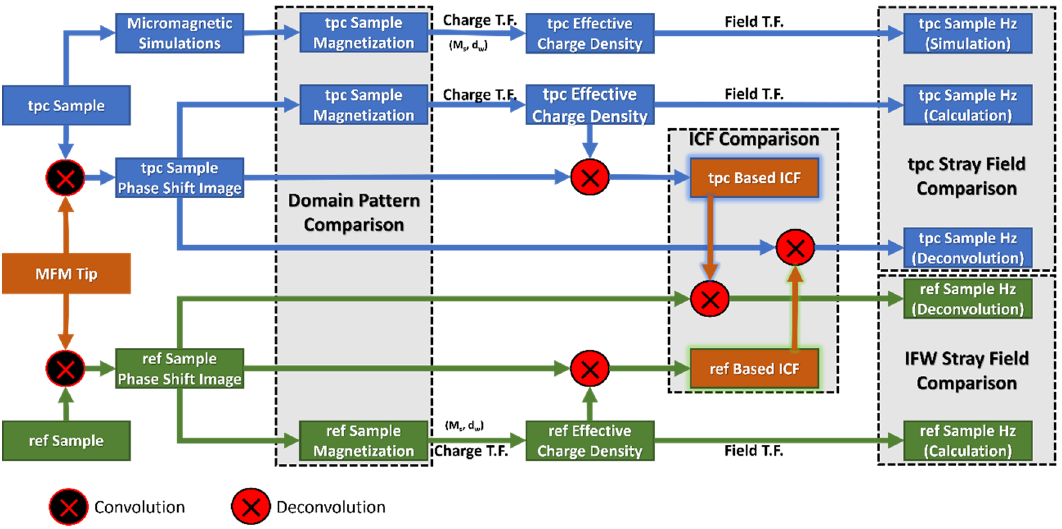
Figure 2. Flowchart of the validation process. The flowchart shows the different simulation and measurement steps used to validate the Ti/Pt/Co sample’s micromagnetic parameters. The comparisons that were performed based on the measurement results are marked as grey shaded